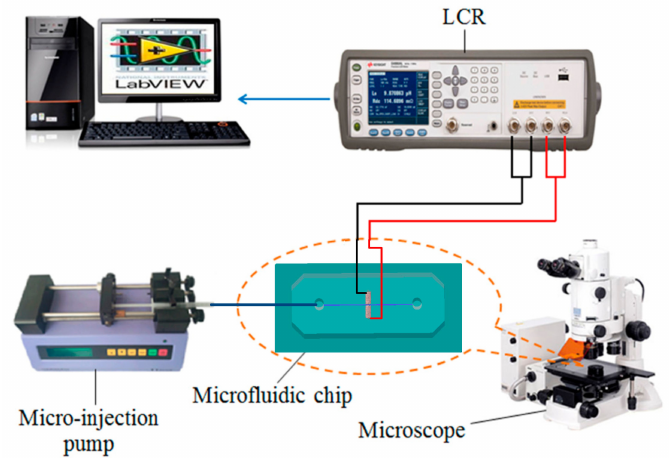
Figure 4. Schematic diagram of the impedance detection